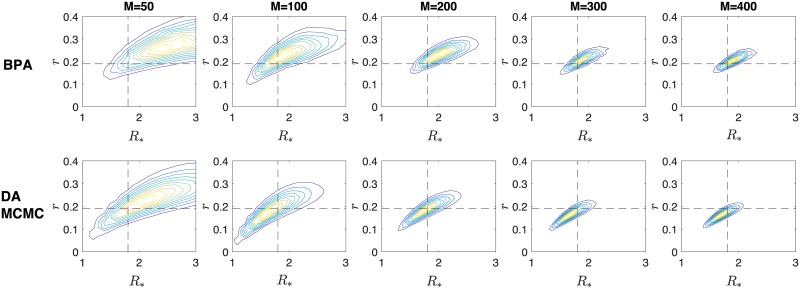
Contour plots of the joint posterior density of R* and r from a single simulation.The top and bottom panels are results from 105 iterations of the BPA and 2.5 × 106 iterations, thinned to 2.5 × 105 samples, of the DA-MCMC algorithm respectively. The panels from left to right are posteriors from inference based upon data with 50, 100, 200, 300 and 400 infected households. The intersection of the black dotted lines indicate the true parameter values at (R*, r) ≈ (1.803, 0.190).